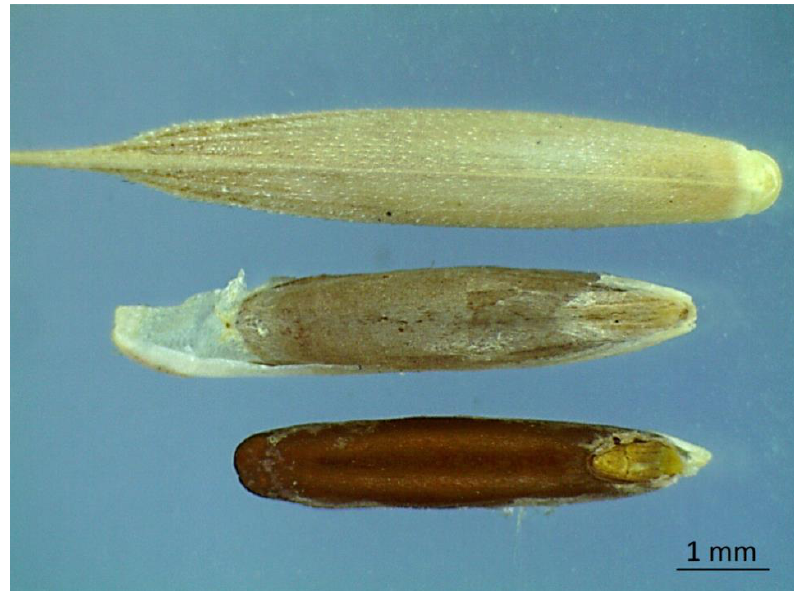
Figure 1. The difference between husked, dehusked with membrane and dehusked without inner membrane grains of Brachypodium hybridum (at 20*0.65 = 13 x magnification under stereomicroscope).